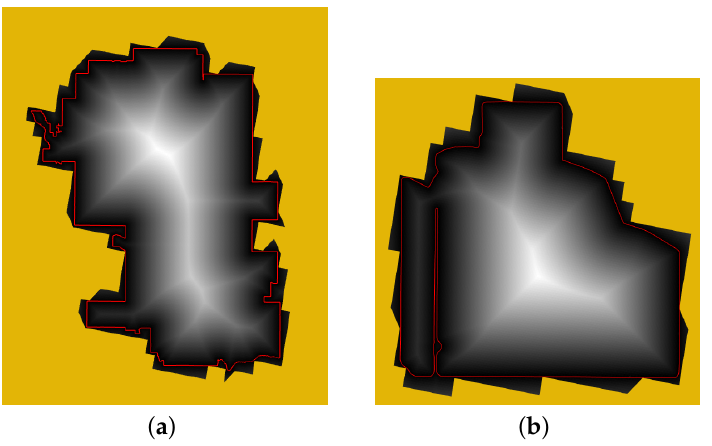
Figure 14. Distance transform for the border of ( a ) the city of Calgary at target resolution 15 (Avg. cell size: 0.016 km 2 ) and ( b ) a farm field in Alberta at target resolution 19 (Avg. cell size: 61.8 m 2 ).